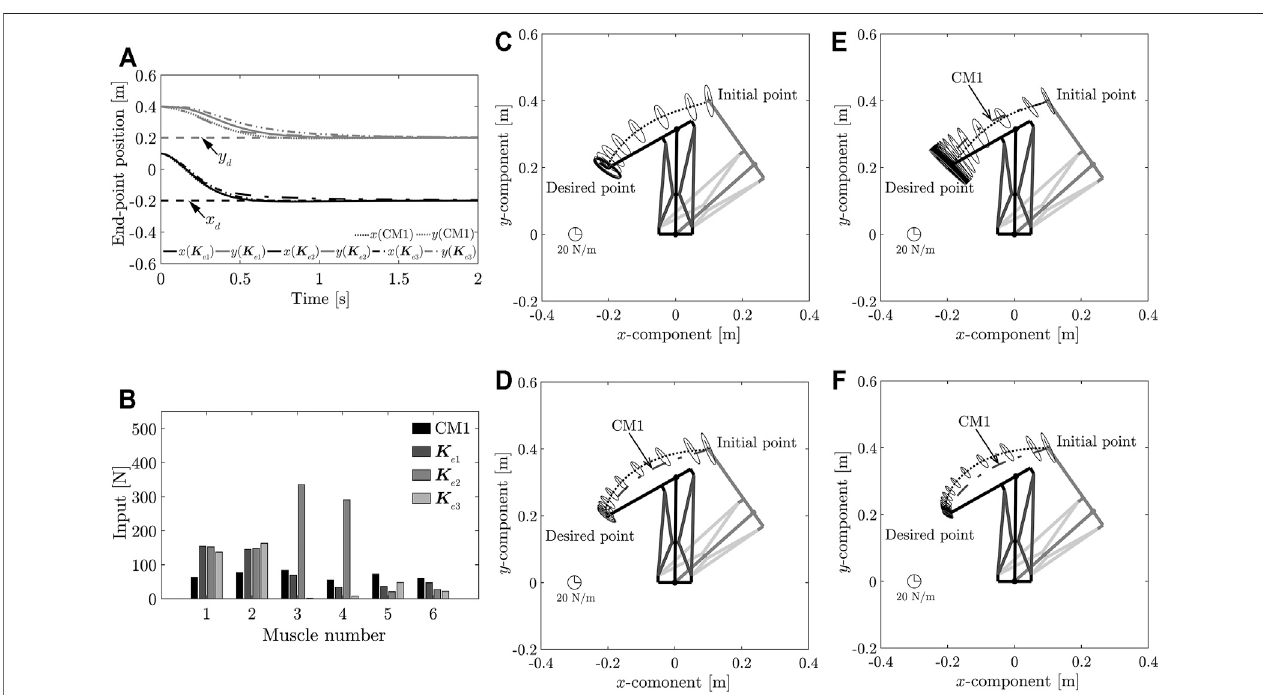
FIGURE 3 | (A) Comparison of transient responses of end-point position at different desired end-point stiffnesses. (B) Comparison of control inputs. (C) Loci of end-point positions and end-point stiffness ellipsoid in the task space produced using CM1. (D) Loci of end-point positions and end-point stiffness ellipsoid in the task space produced using the stiffness matrix K e 1 . (E) Loci of end-point positions and end-point stiffness ellipsoid in task space obtained using the stiffness matrix K e 2 . (F) Loci of end-point positions and end-point stiffness ellipsoid in task space obtained using the stiffness matrix K e 3 .